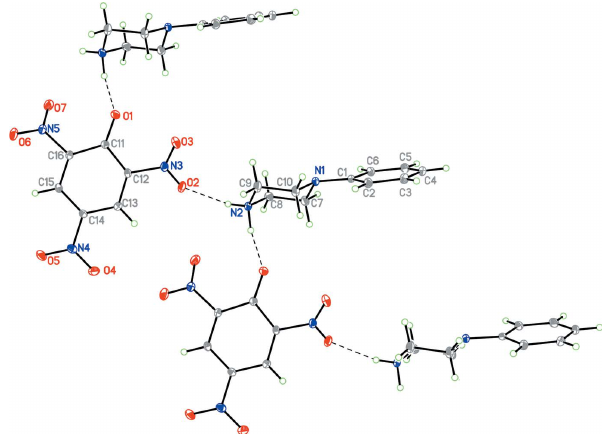
Figure 20 Partial packing diagram for 8 showing the C 2 H (cid:2)(cid:2)(cid:2) O hydrogen bonds involving the phenylpiperazinium cation and a nitro group of the picrate anion. Hydrogen-bonding interactions are shown by dashed